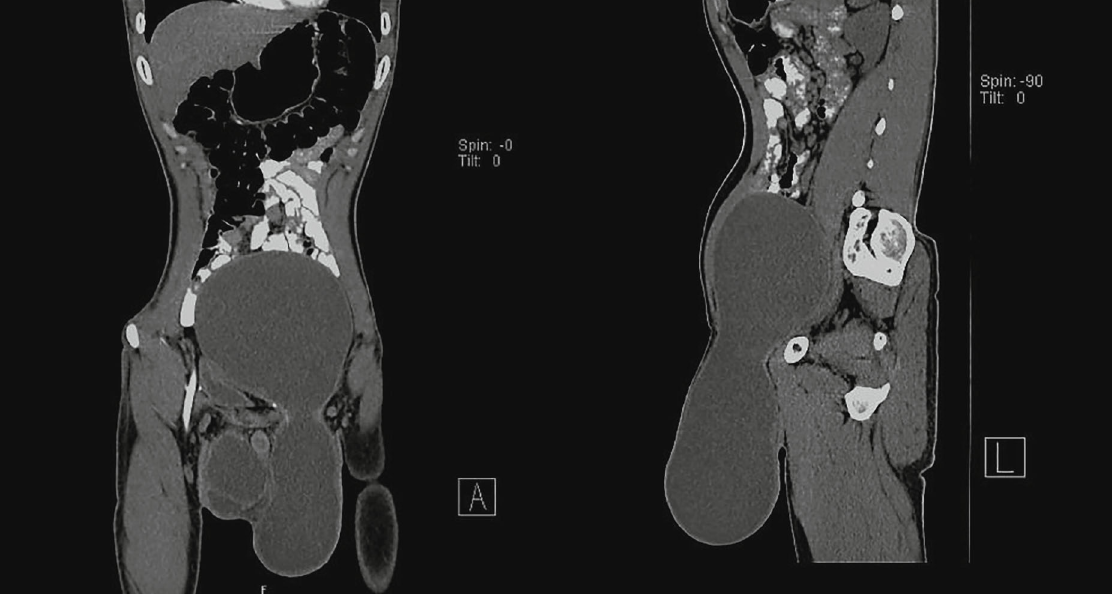
Figure 2: CECT showing hourglass appearance of ASH with intercommunicating scrotal and abdominal